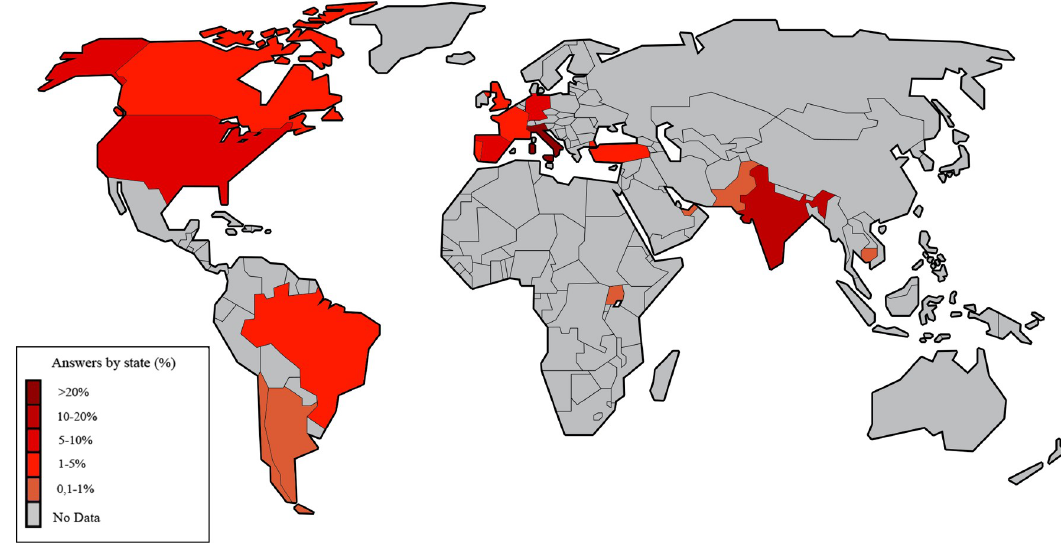
Fig 2. Distribution of respondents. World map is reprinted from https://commons.wikimedia.org/wiki/File:Simple_world_map_ edit.svg under a CC BY 4.0 license, with permission from “Wikimedia Commons, the free media repository”, original copyright 2019.